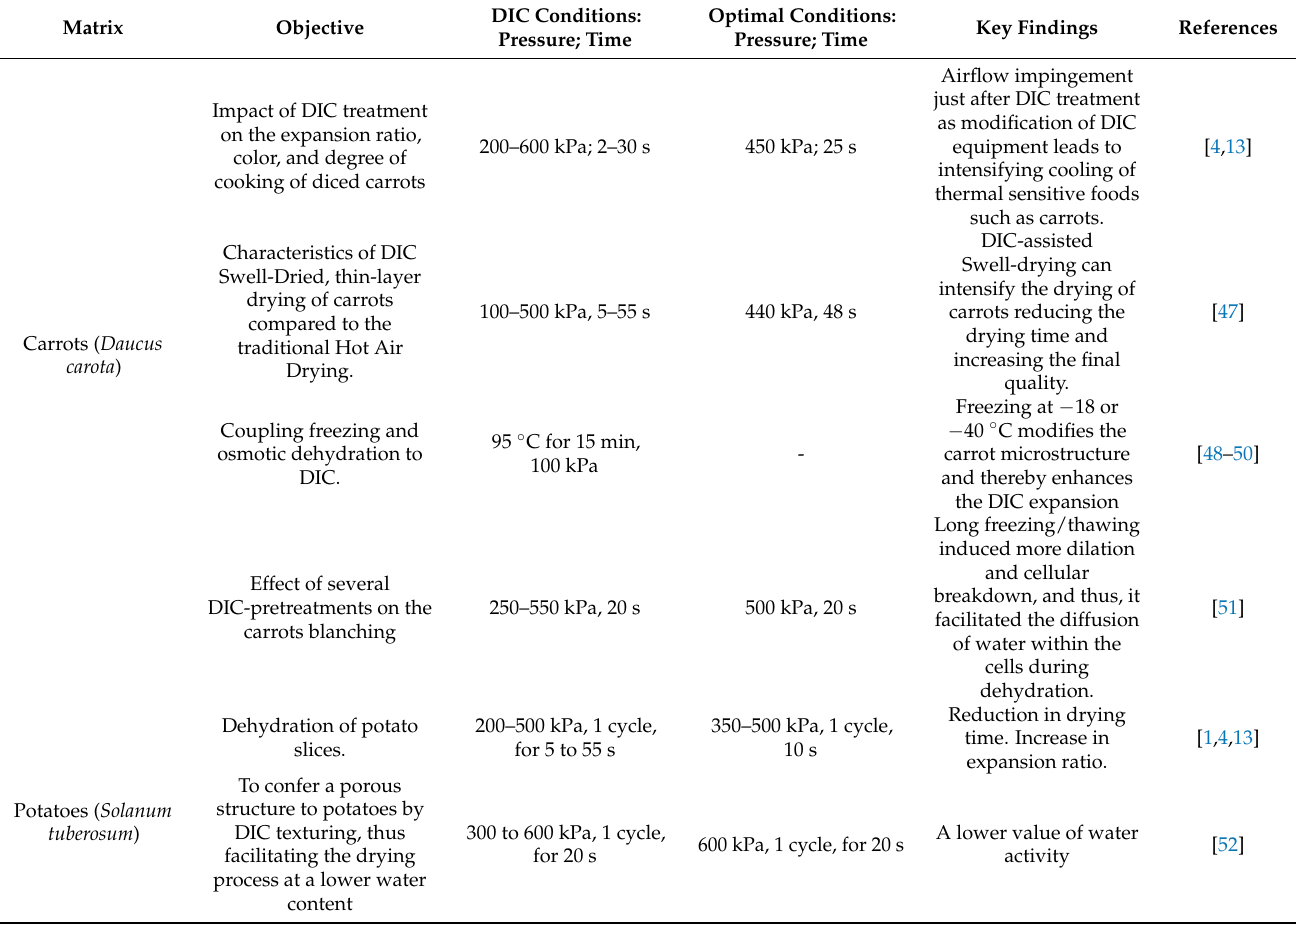
Table 3. DIC conditions to treat vegetables and some key